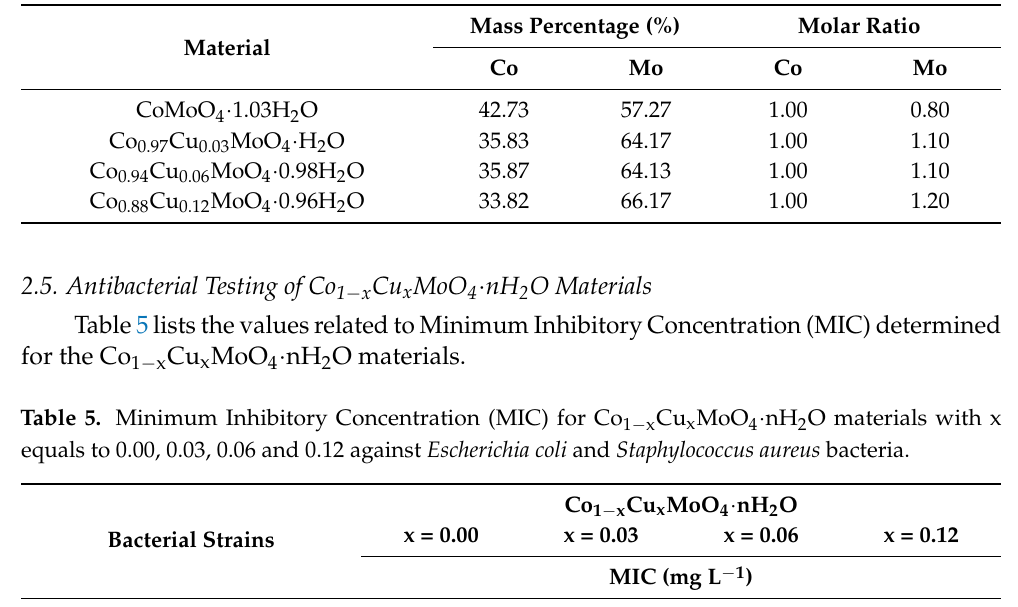
Table 4. MasspercentageandmolarratiosofCo, MotakenfromEDSspectraintheCo 1 − x Cu x MoO 4 · nH 2 O compounds.